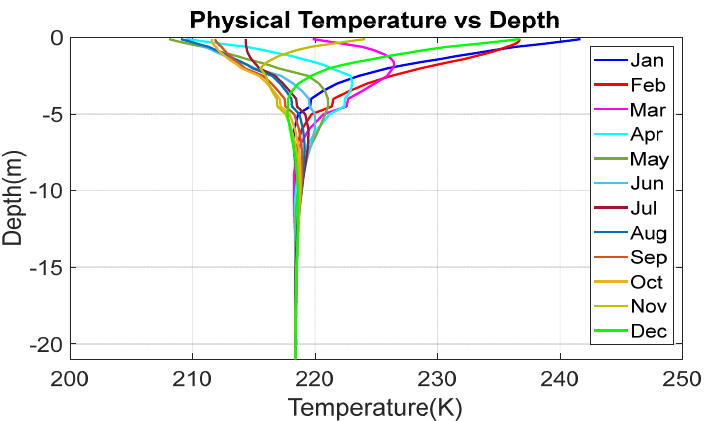
Figure 4. Monthly averaged in situ firn temperature measurements versus depth at Concordia Station between 2006 and 2010. Data have been obtained from [16].